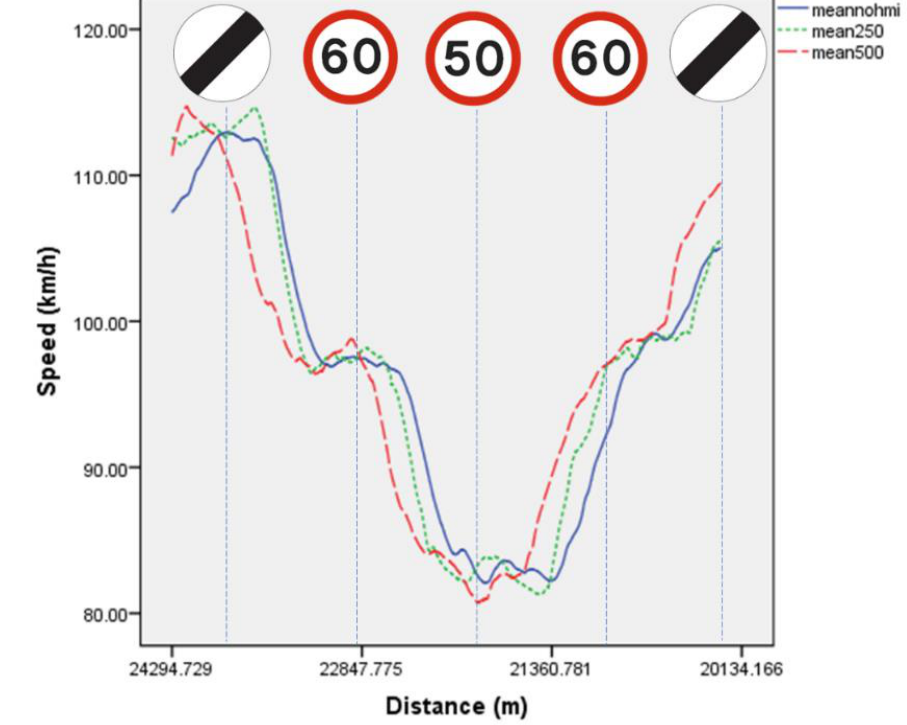
Figure 7. Plot of the mean speed in the noHMI condition (n = 20), the trig250 m condition (n = 10) and the trig500 m condition (n = 10). The locations of the overhead gantries are illustrated with the dashed vertical lines, representing the 70 mph, 60 mph, 50 mph, 60 mph and 70 mph overhead gantries, respectively. the speed value in mph to be congruent with the speed limits signs. None of the partici- pants used the brakes to decelerate, they only used the engine deceleration. Partial eta squared values are presented in the different tables.